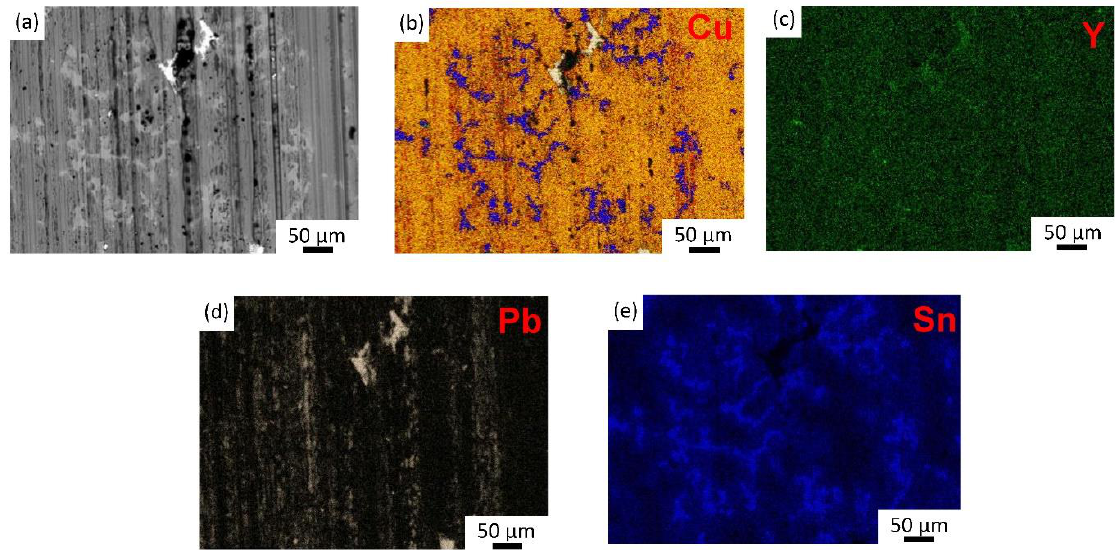
Figure 10. ( a ) BSE image and the EDS mapping results of ( b ) Cu, ( c ) Y, ( d ) Pb, and ( e ) Sn for the alloy containing 0.15% Y after the friction and wear test.